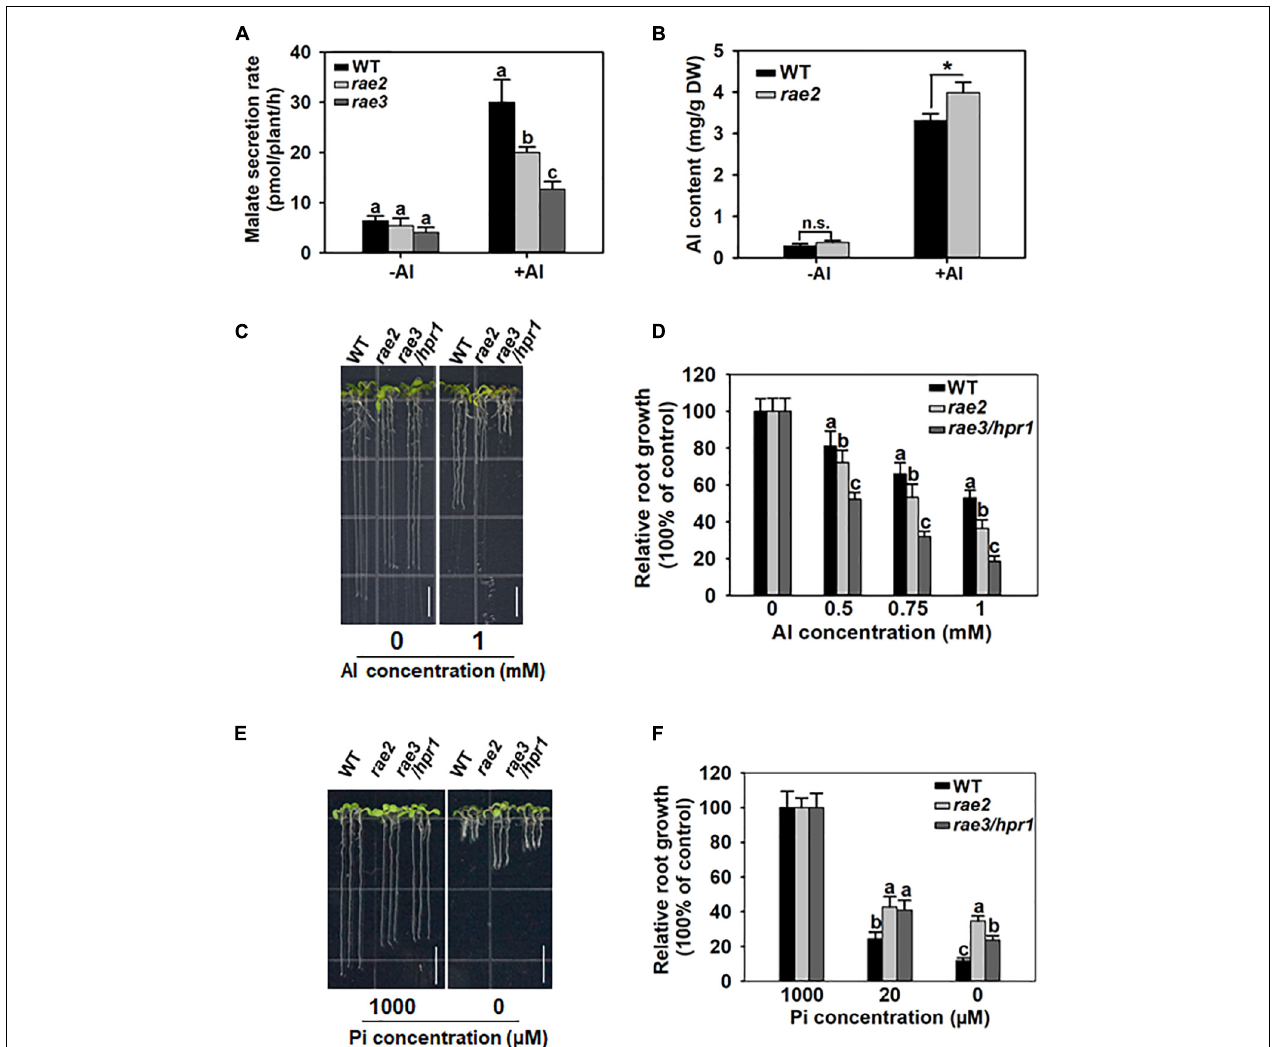
FIGURE 2 | Mutation of RAE2 reduces Al resistance and low Pi response. (A) Malate secretion was reduced in rae2 compared to WT under +Al conditions. Five-day-old seedlings of WT, rae2 , and rae3 were treated with 0 (–Al) or 20 µ M Al (+Al) for 12 h, and then root exudates were collected for malate content determination. Values are means ± SD of three biological replicates. (B) rae2 mutant accumulated a higher level of Al than WT. Three-week-old plants of WT and rae2 were exposed to 0 (–Al) or 30 µ M Al (+Al) at pH 4.8 for 12 h, and the roots were harvested for the measurement of Al content. Values are means ± SD of three biological replicates. Asterisks indicate that the values are statistically different (Student’s t -test, * P < 0.001). (C,D) Representative images (C) and relative root growth (D) of WT, rae2 , and rae3 at different Al concentrations. Seedlings of WT, rae2 , and rae3 were grown on a soaked gel medium containing 0, 0.5, 0.75, or 1 mM Al for 7 days, and then the relative root growth was calculated to determine their Al resistance. Values are means ± SD ( n = 16–20). Bar = 7 mm. (E,F) Images (E) and quantitative data (F) of low Pi-response phenotype in WT, rae2 , and rae3 . Seedlings were grown on gellan gum medium containing 0, 20 or 1,000 µ M Pi for 7 days, and the relative root growth was used to evaluate the low Pi response. Bar = 7 mm. Values are means ± SD ( n = 15–20). Different letters at each treatment indicate that the values are significantly different ( P < 0.05, ANOVA followed by Tukey’s test).